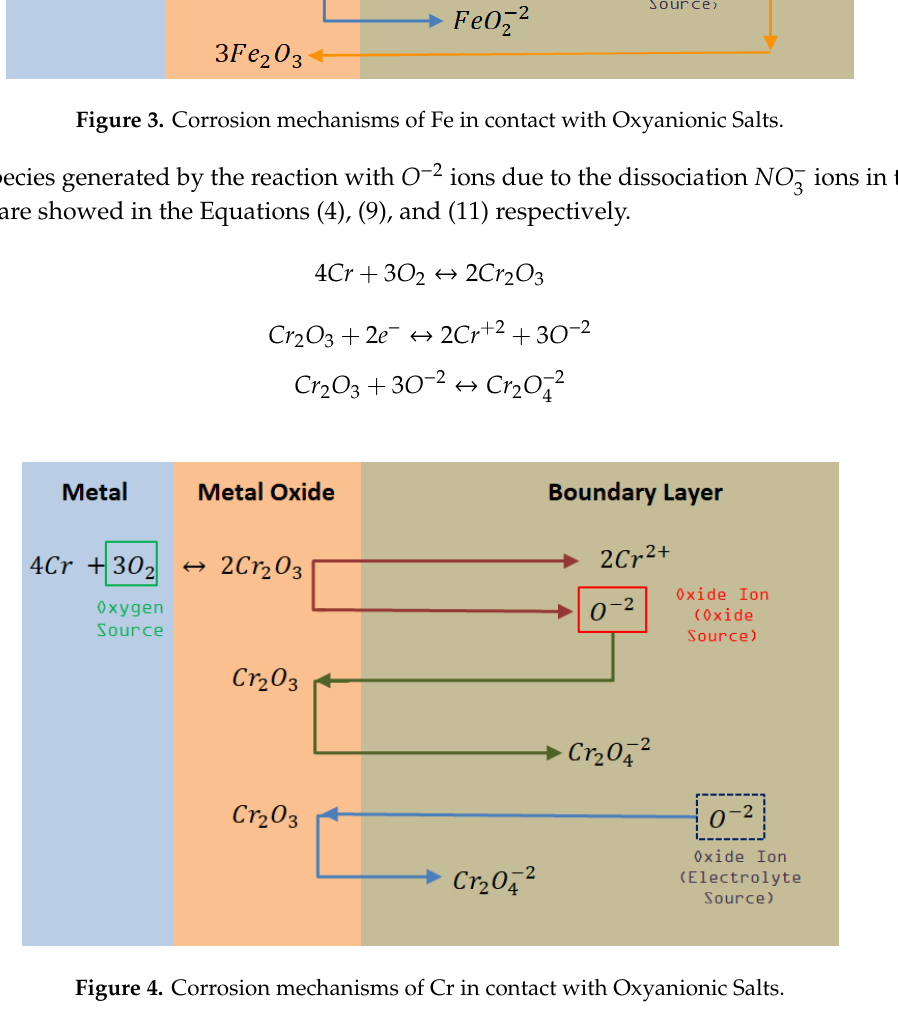
Figure 5. Corrosion mechanisms of Ni in contact with Oxyanionic Salts. According to the reaction mechanism of nickel in Figure 5, NiO can be dissociated in acid/basic medium through the activity of the oxide ion 𝑂 (cid:2879)(cid:2870) , resulting in potentially soluble nickel oxide ions. Therefore, the formation of different nickel anions is clearly seen as 𝑁𝑖𝑂 (cid:2870)(cid:2879)(cid:2870) , 𝑁𝑖𝑂 (cid:2870)(cid:2879) y 𝑁𝑖𝑂 (cid:2871)(cid:2870)(cid:2879) .